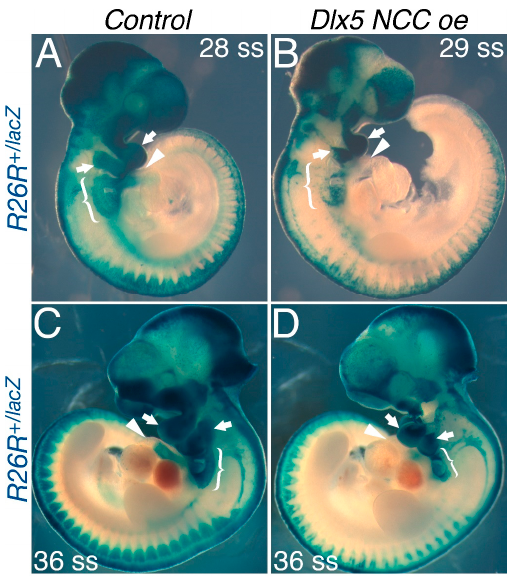
Figure 4. NCC lineage analysis of Dlx5 NCC oe E9.5 and E10.5 embryos. ( A ) E9.5 Wnt1-Cre; R26R lacZ /+ embryo stained for β -galactosidase activity. Blue stained cells represent NCC migration through the embryo. Cranial NCCs populating the first and second pharyngeal arches are noted by arrows. Cardiac NCCs occupying the caudal pharyngeal arches are denoted by brackets. NCCs within the outflow tract (OFT) are denoted by arrowheads. ( B ) NCC lineage analysis in Dlx5 NCC oe embryos shows reduced first and second pharyngeal arch size (arrows) and reduced cardiac NCC number dorsal to and within the OFT. ( C ) Control and ( D ) Dlx5 NCC oe embryo NCC lineage analysis at E10.5 demonstrate that the cranial arches are hypoplastic in Dlx5 NCC oe embryos when compared to control embryos (arrows). Reduced numbers of cardiac NCCs (brackets) and NCCs within the OFT (arrowheads) are also